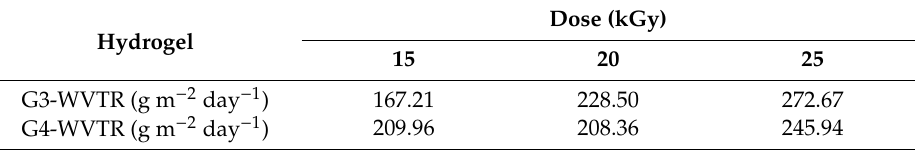
Table 5. Water vapor transmission rate of hydrogels.